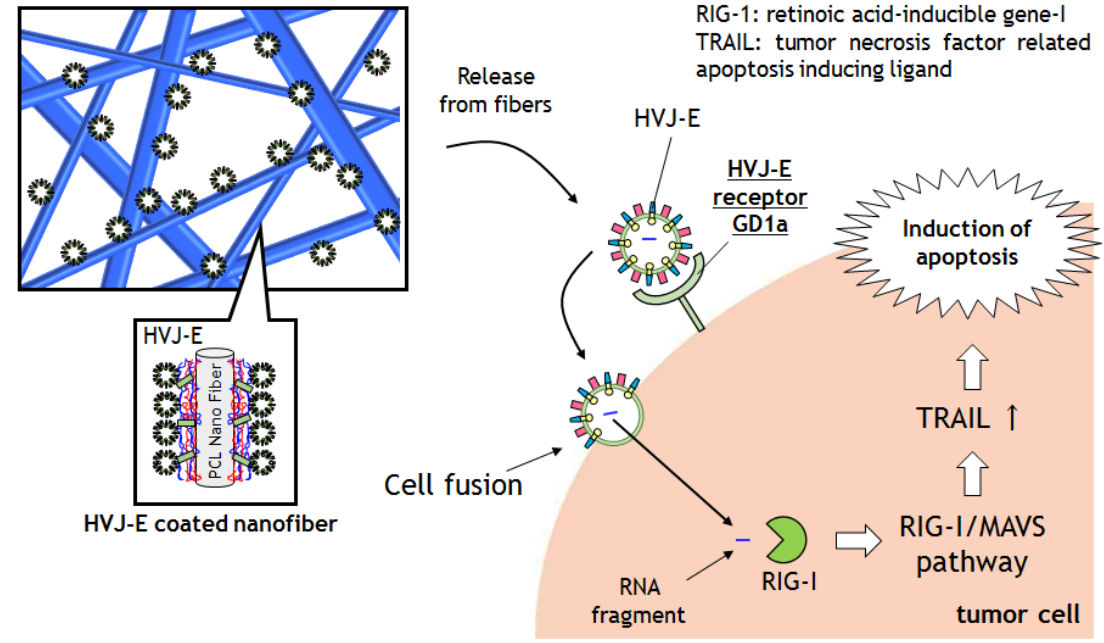
Figure 1. Schematic illustrations of HVJ ‐ E coated nanofiber meshes and the mechanism of cancer apoptosis induced by the released HVJ ‐ E particles from nanofiber.